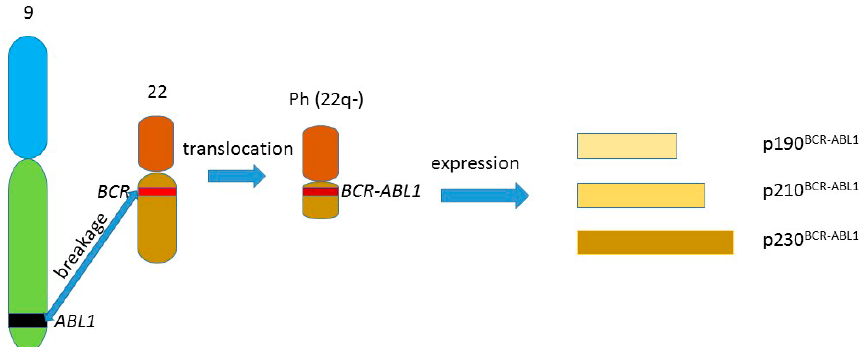
Figure 1. The t(9;22)(q34;q11) reciprocal chromosomal translocation producing the Philadelphia chromosome (Ph) (22q–), containing the BCR-ABL1 gene, the expression of which can give three fusion proteins of different lengths due to alternative splicing of the BCR-ABL1 mRNA. The other product of the translocation—the 9q+ chromosome, is not included in the figure.